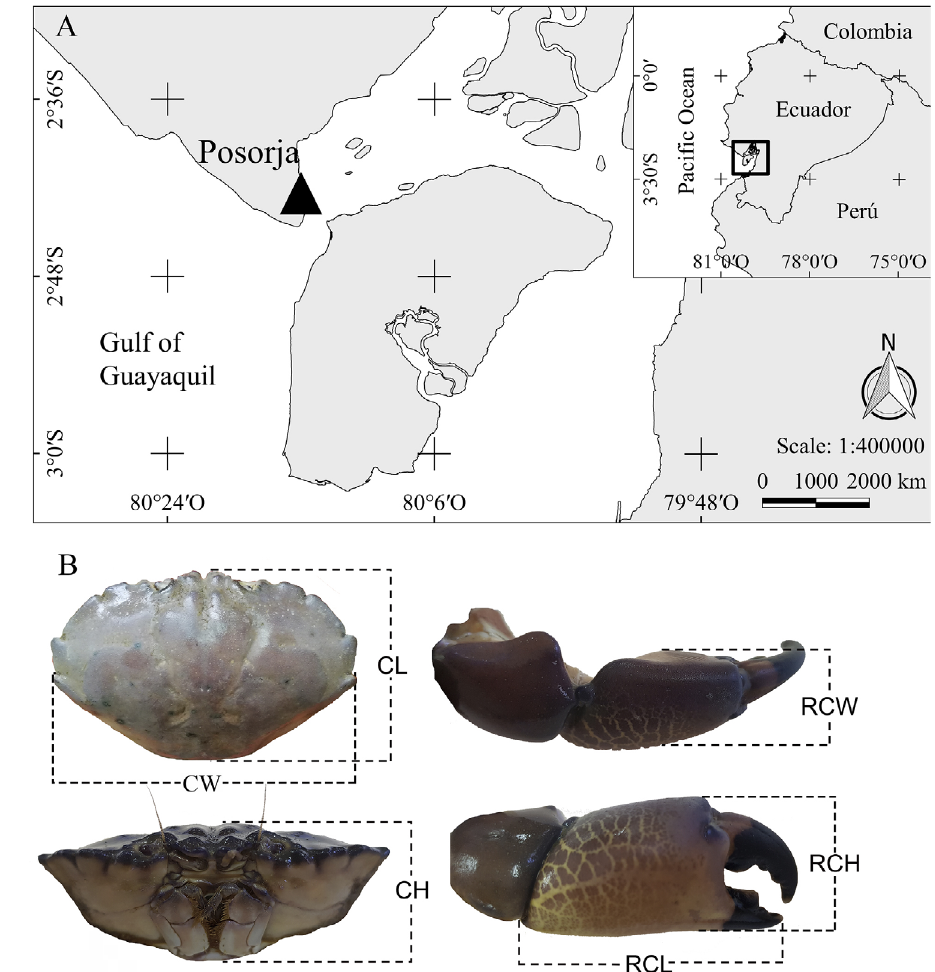
Figure 1. A: Sampling site in Posorja, Gulf of Guayaquil, Ecuador. B: Morphometric variables recorded for Menippe frontalis. CL, carapace length; CW, carapace width; CH, carapace height; RCW, right chela width; RCH, right chela height; RCL, right chela